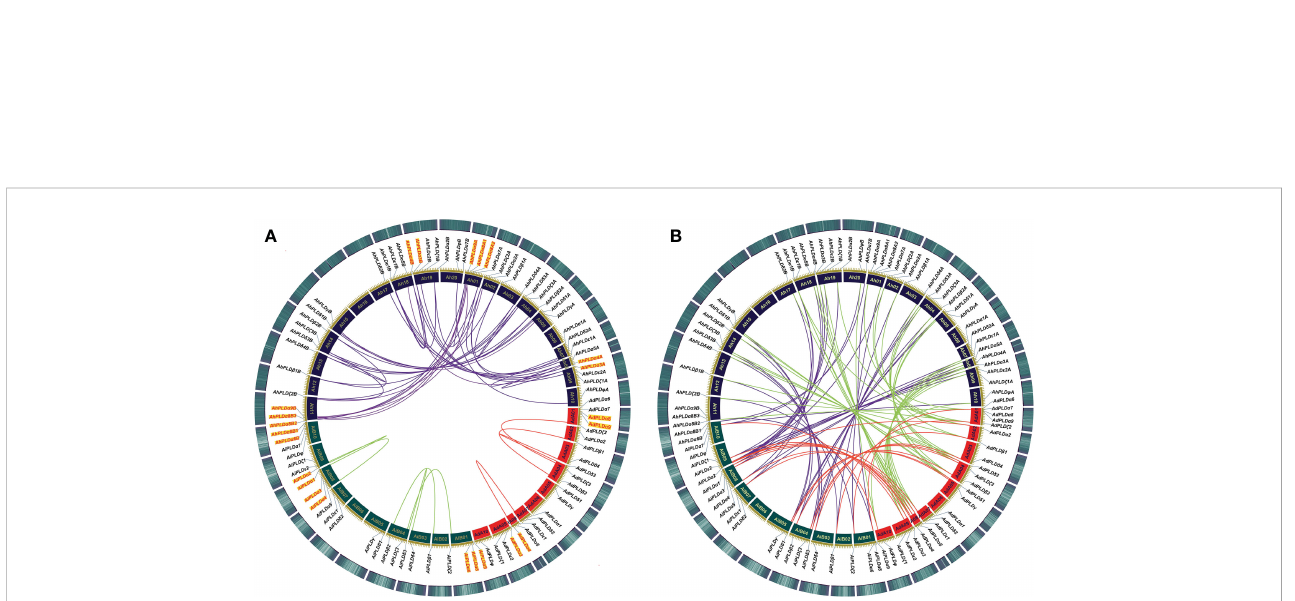
FIGURE 5 Syntenic relationships among PLD genes in peanut and its two progenitors. (A) Syntenic relationships of PLD genes within A . duranensis , A . ipaensis and A . hypogaea , respectively. (B) Syntenic relationships of PLD genes between A . duranensis , A . ipaensis and A . hypogaea . The chromosomes of A . duranensis , A . ipaensis and A . hypogaea were shown with red, dark green and dark purple colors, respectively. The putative homologous PLD genes are linked by different colored lines. The tandem duplicated PLD genes are marked with red font next to the